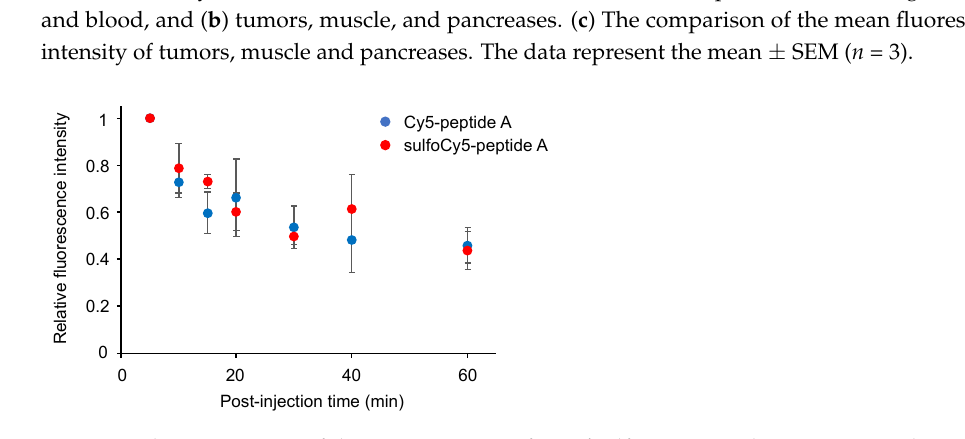
Figure 7. The time course of the concentration of Cy5/sulfoCy5-peptide A in mouse plasma. The data represent the mean ± SEM ( n = 3).